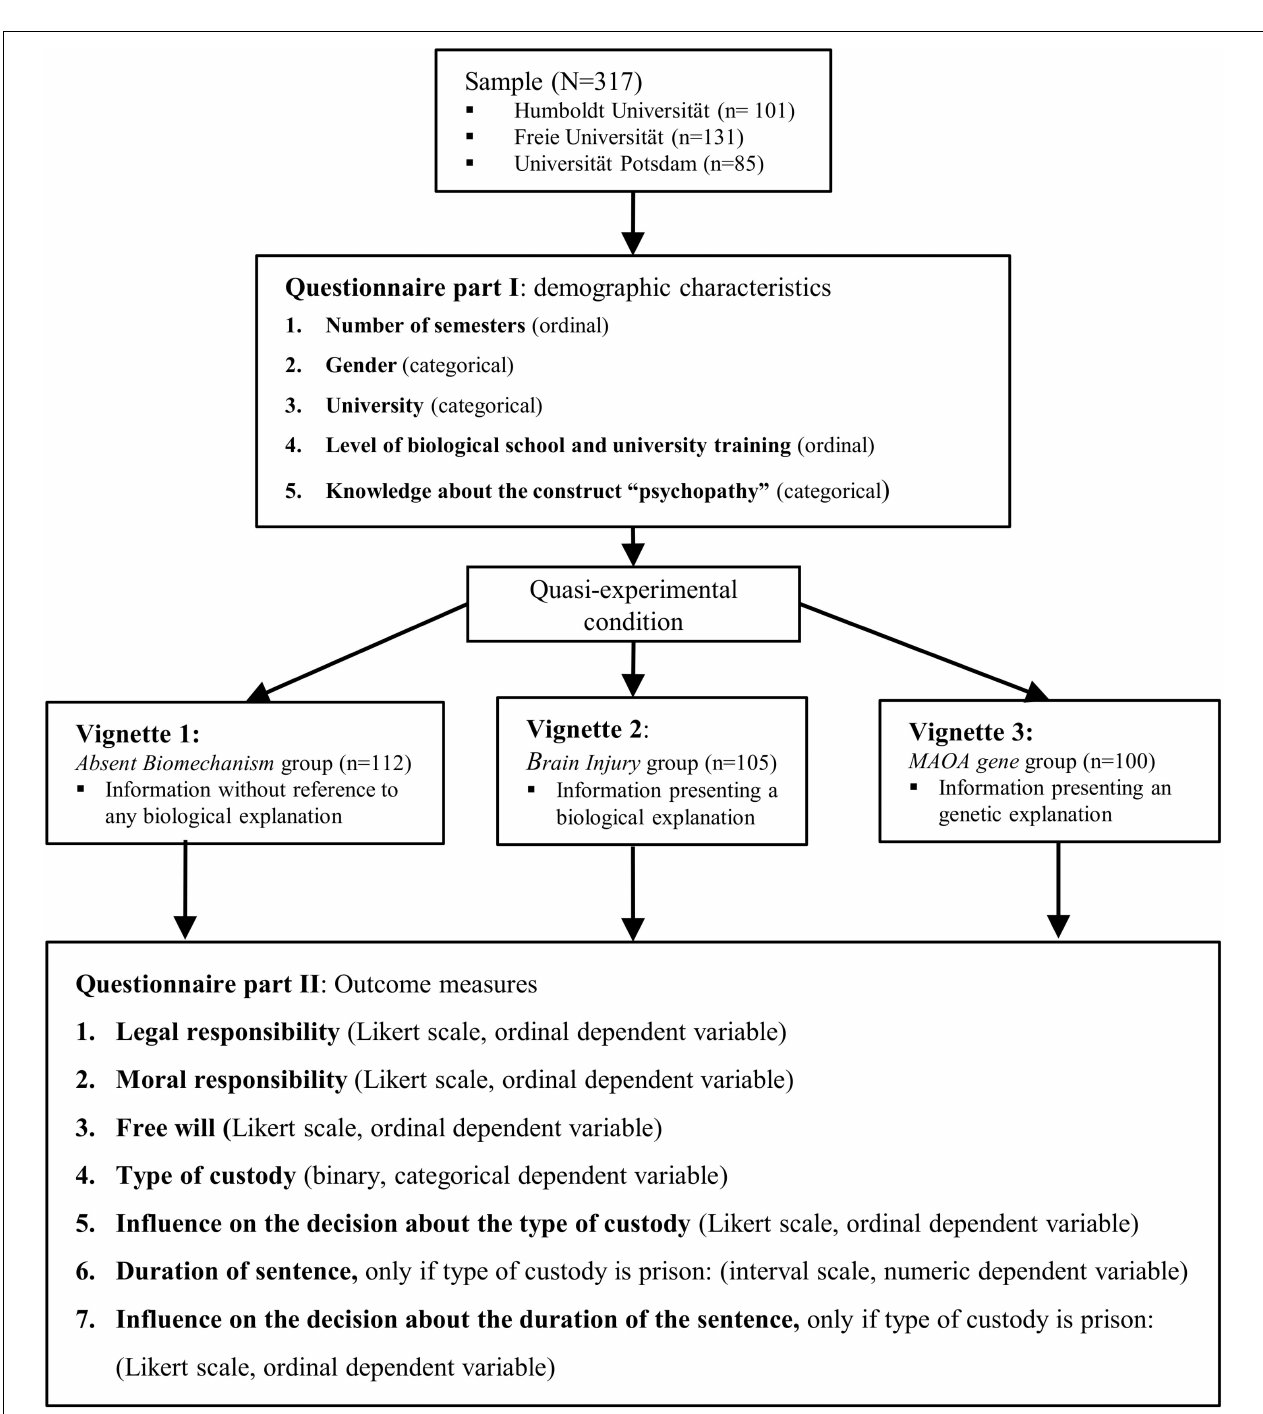
FIGURE 1 | Flow chart displaying the experimental design of this vignette study and the participant flow as required by the CONSORT statement (Schulz et al., 2010).